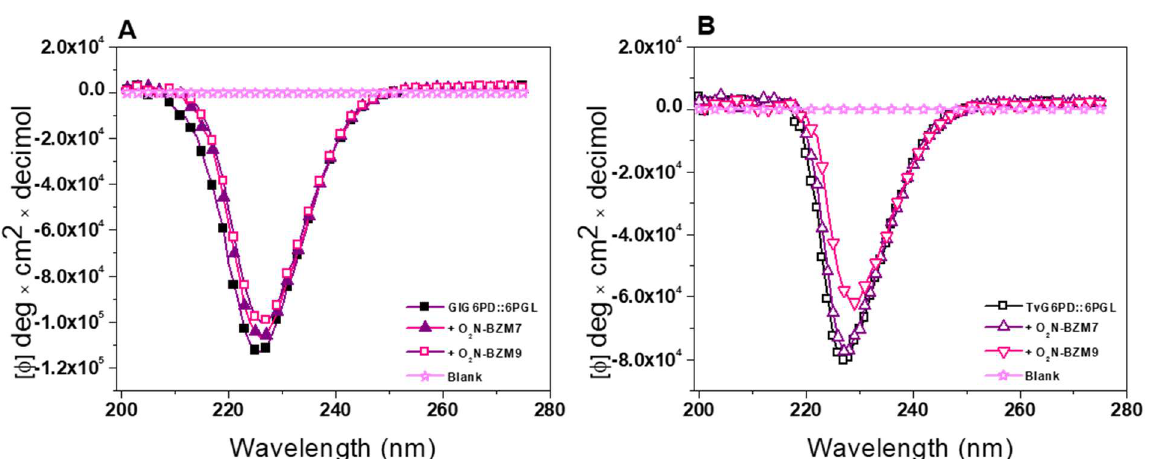
Figure 5. Spectroscopic characterization of enzymes. ( A ) Far-ultraviolet circular dichroism (CD) spectra of the enzyme GlG6PD::6PGL and ( B ) TvG6PD::6PGL. Changes in molar ellipticity were monitored by circular dichroism. The protein was adjusted to 0.5 mg/mL in 50 mM phosphate buffer and incubated with the benzimidazole compounds at the IC 50 concentration of each inhibitor for 2 h at 37 °C before measuring. The results shown are representative of triplicate experiments.